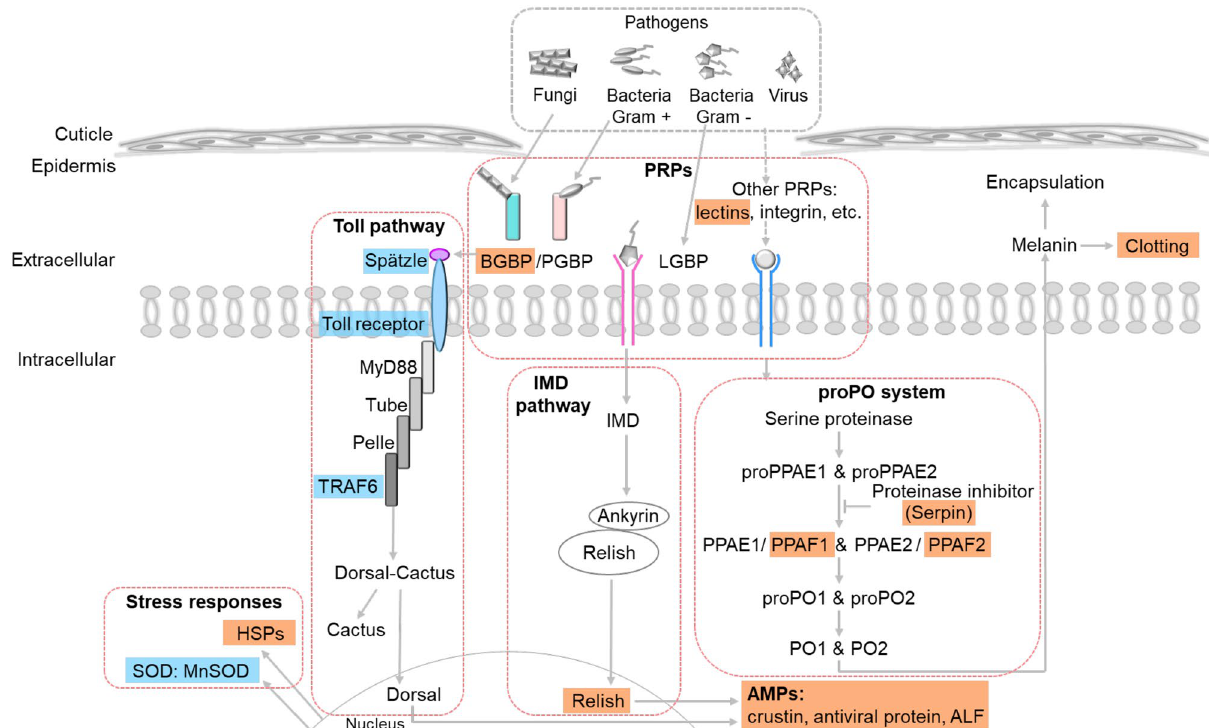
Figure 6. Schematic model of shrimp immune system in early life stages of P. monodon , including nauplius, zoea, mysis and 15-day-old postlarva. Pattern recognition proteins (PRPs) (beta 1,3-glucan binding protein (BGBP), lipopolysaccharide and beta 1,3-glucan binding protein (LGBP) and lectin), prophenoloxidase system (proPO system) (prophenoloxidase-activating factor 1 (PPAF1), prophenoloxidase-activating factor 2 (PPAF2) and serpin), antimicrobial peptides (AMPs) (crustin, anti-lipopolysaccharide factor (ALF) and antiviral protein), blood clotting system, Toll pathway (toll receptor, Spätzle and tumor necrosis factor receptor- associated factor 6 (TRAF6)), IMD pathway (Relish) and stress responses (heat shock proteins (HSPs) and manganese superoxide dismutase (MnSOD) were involved in early life stages of shrimp. Blue box represents transcript expression found associated with the four larval stages, while orange box represents an immune gene with increasing expression pattern during the development. The compotents in shrimp immune pathways were adapted from previous studies 31